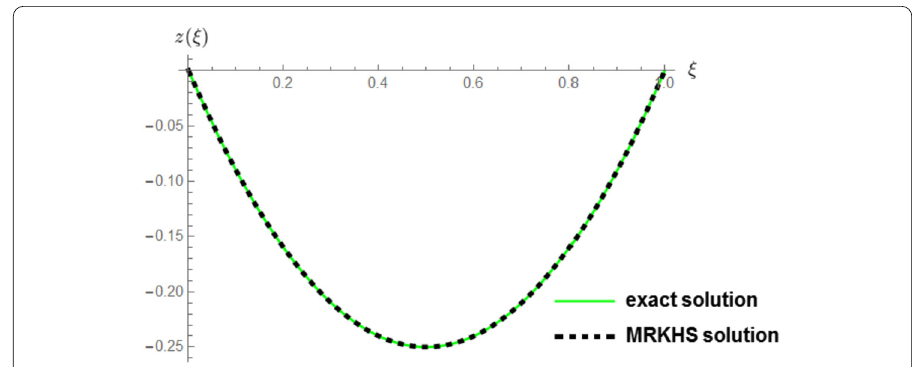
Figure 6 Exact and MRKHS solution curves of Example